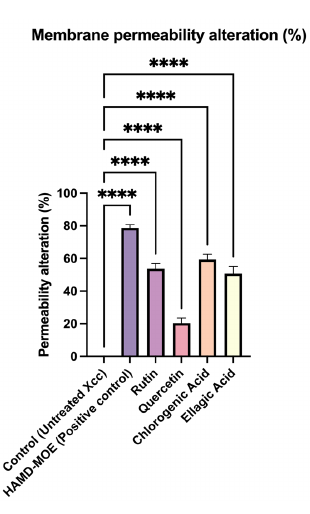
Figure 1. In vitro membrane permeability assay. X. campestris pv. campestris permeability was assessed by PI intake compared to untreated control. Data represent average of three independent experiments on three copies (mean ± standard deviation), and values are given as percentages; **** p < 0.001. Complete statistical analysis can be found in Supplementary Table S3. The analysis performed on the activity of single strains can be found in Supplementary Figure S1.